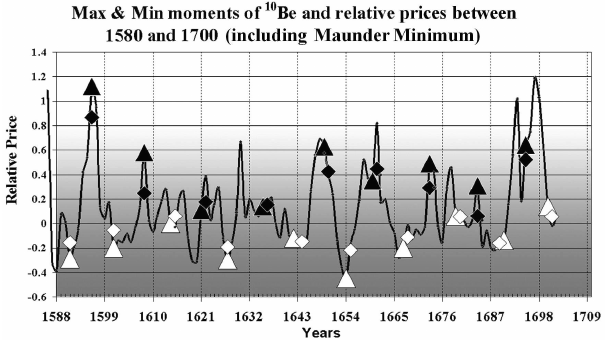
Fig. 8. Comparison of observed galactic CR variations during about 50yr (as 11 month moving averaged at Climax NM) − ln(CL11M- OBS) with predicted in the frame of convection-diffusion and drift modulations ln(CL11M-PRED). According to Dorman